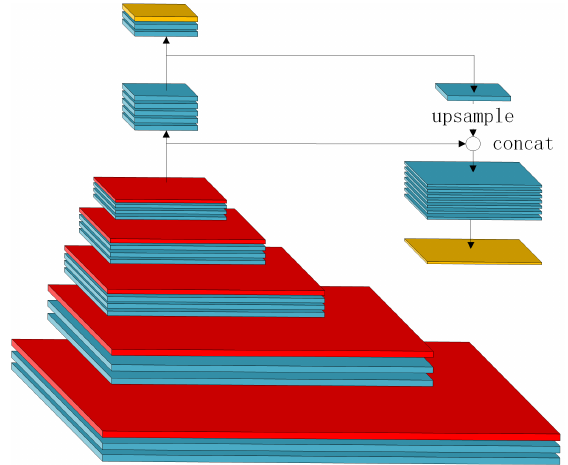
Figure 2. Network structure of detection algorithms. The blue layers are convolutional layers, the red layers are max-pooling layers, and the yellow layers are detection